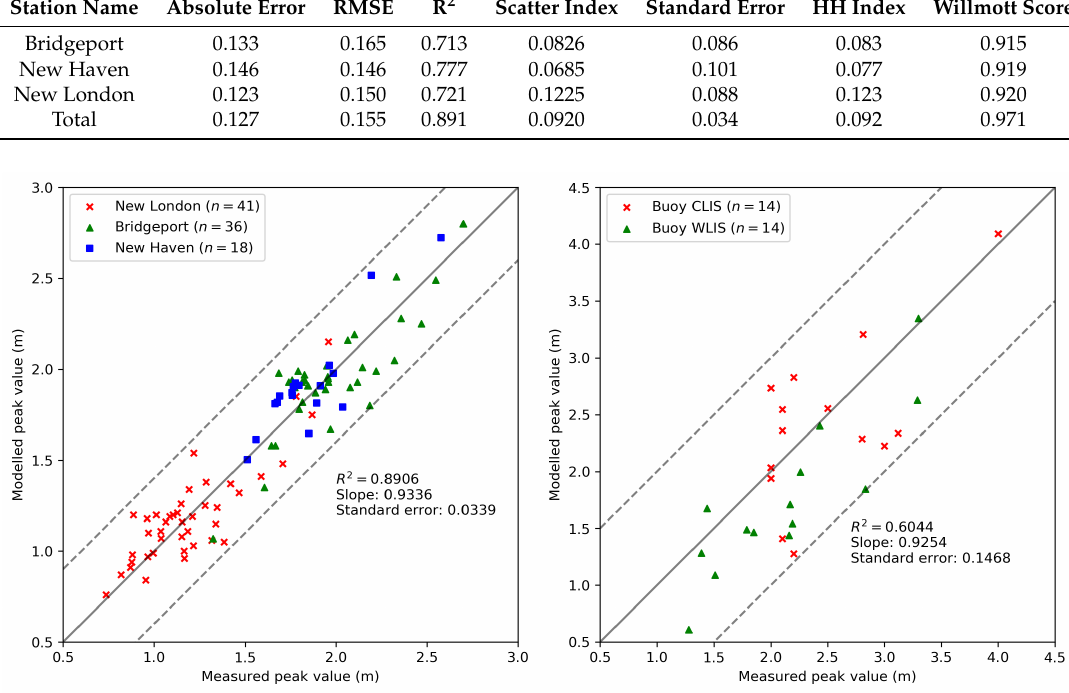
Figure 4. Comparison of observed and modeled peak values for water level ( left ) and significant wave height ( right ) at tide gauge stations and buoys during storm